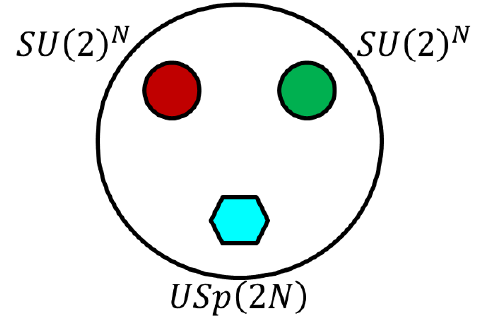
Figure 1 . The trinion for the D N +3 minimal conformal matter obtained in this paper. The trinion has a quiver description with N = 1 SU(2) gauge nodes. The two factors of SU(2) N global symmetry are manifest in the UV Lagrangian. The USp(2 N ) symmetry appears only in the IR as enhancement of a UV U(1) N global